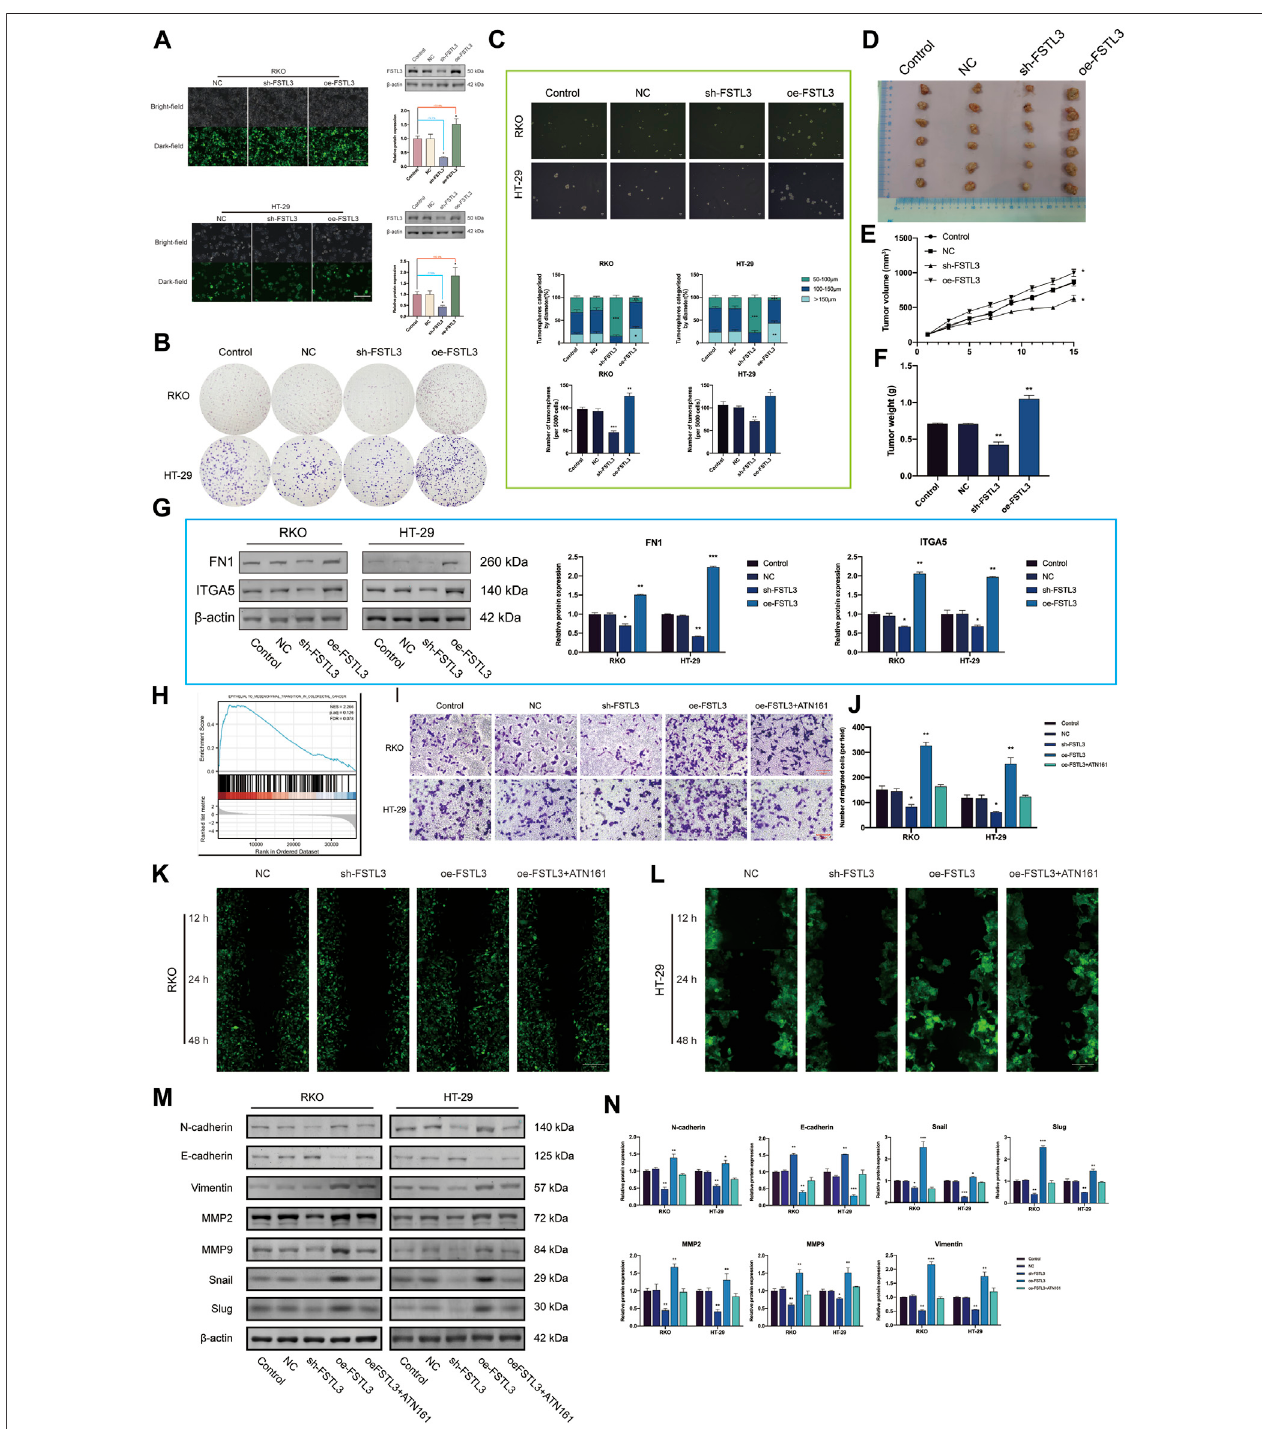
FIGURE4| FSTL3 overexpressionpromotes amalignantphenotype incolorectal cancer(CRC). (A) Thetransfection ef fi ciencywasveri fi edbytheGFP expression aswellasthewesternblot.Transfectionef fi ciencyisrepresentedaspercentages. (B) CloneformationcapacityoftheCRCcellstransfectedwiththeNC,sh- FSTL3 ,and oe- FSTL3 constructs assessed using the clone formation assay. (C) Representative images from the sphere-forming assay. The number oftumorspheres was counted and plotted, and percentage of tumorspheres with diameters of 50 – 100 μ m, 100 – 150 μ m, or > 150 μ m was calculated and plotted. The scale bar represents 100 μ m. (D) The xenograft tumors from the nude mice. (D – F) (E) Tumor volume and (F) weight of xenografts from the nude mice. (G) FN1, ITGA5 levels in CRC cells transfected with NC, sh- FSTL3 , and oe- FSTL3 were examined using western blot. (H) Gene Set Enrichment Analysis (GSEA) of FSTL3. (I,J) The invasion ability of CRC